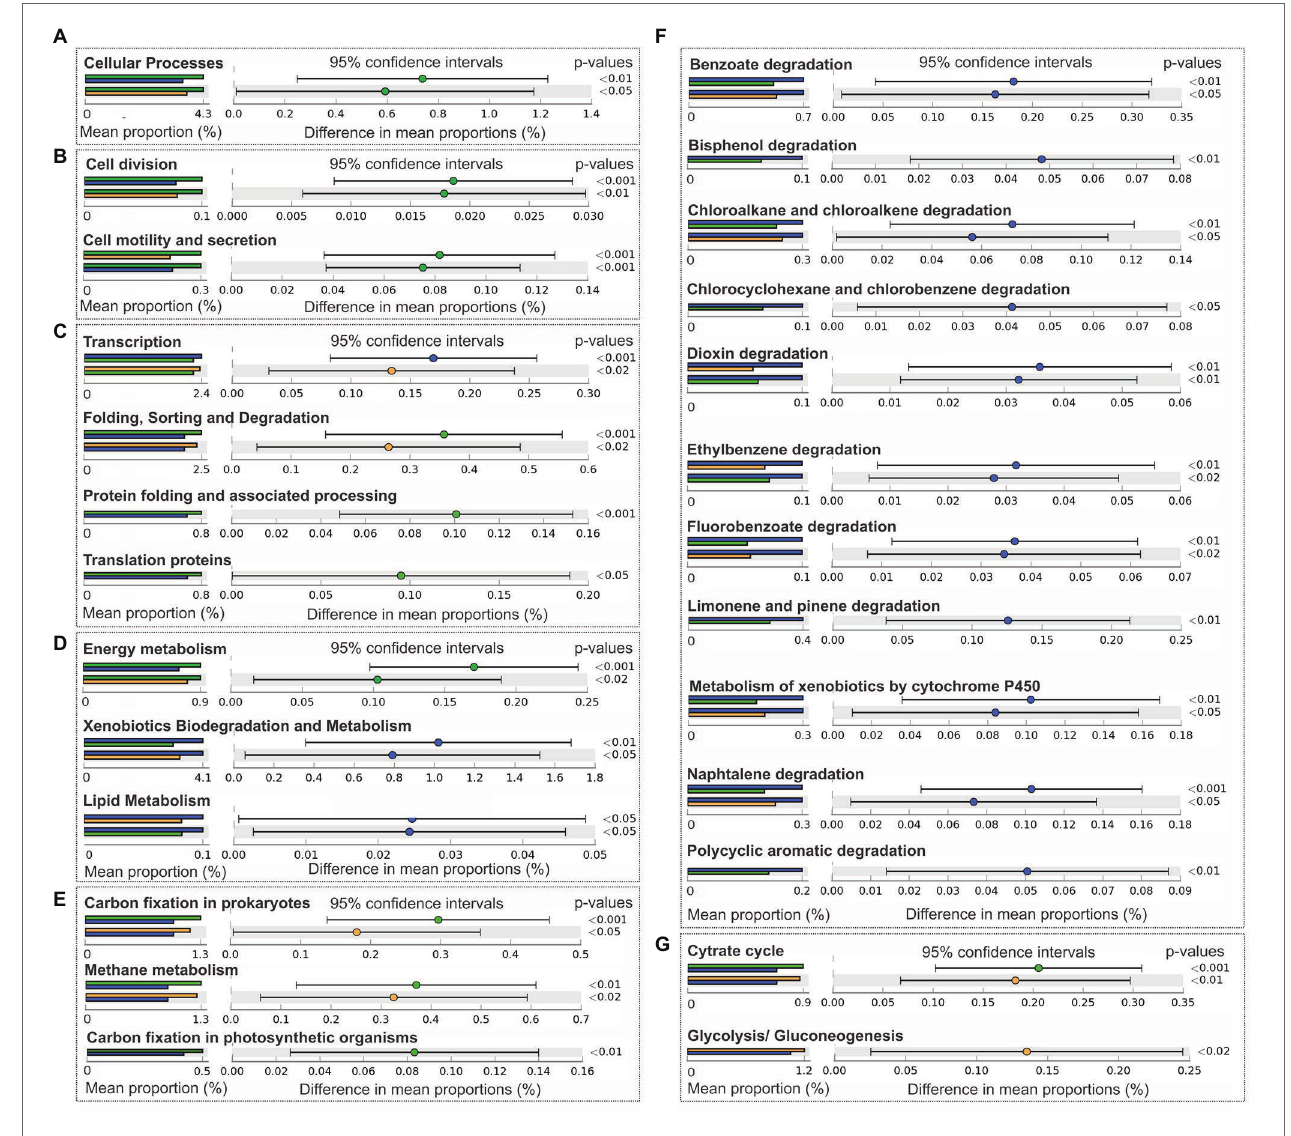
FIGURE 5 | Comparison of predictive functions at Level 1, Level 2, and Level 3 of KEGG categories (PICRUSt) between bacterial communities from Group 1 (green), Group 2 (orange), and Group 3 (blue). (A) Cellular processes (Level 1). (B) Subcategories cellular processes and signaling: cell division and cell motility and secretion (Level 2). (C) Genetic information processing: transcription, folding sorting and degradation, Protein folding and associated processing, and translation proteins and metabolism (Level 2). (D) Metabolism: energy metabolism, xenobiotic degradation and metabolism, and lipid metabolism (Level 2). (E) Energy metabolism: carbon fixation by prokaryotes, methane metabolism, and carbon fixation in photosynthetic organisms (Level 3). (F) Subcategories xenobiotics degradation and metabolism: benzoate degradation, bisphenol degradation, chloroalkane and chloroalkene degradation, chlorocyclohexane and chlorobenzene degradation, dioxin degradation, ethylbenzene degradation, fluorobenzoate degradation, limonene and pinene degradation, metabolism by xenobiotics by cytochrome 450, naphthalene degradation, and polycyclic aromatic degradation. (G) Carbohydrate metabolism: cytrate cycle, glycolysis, and gluconeogenesis (Level